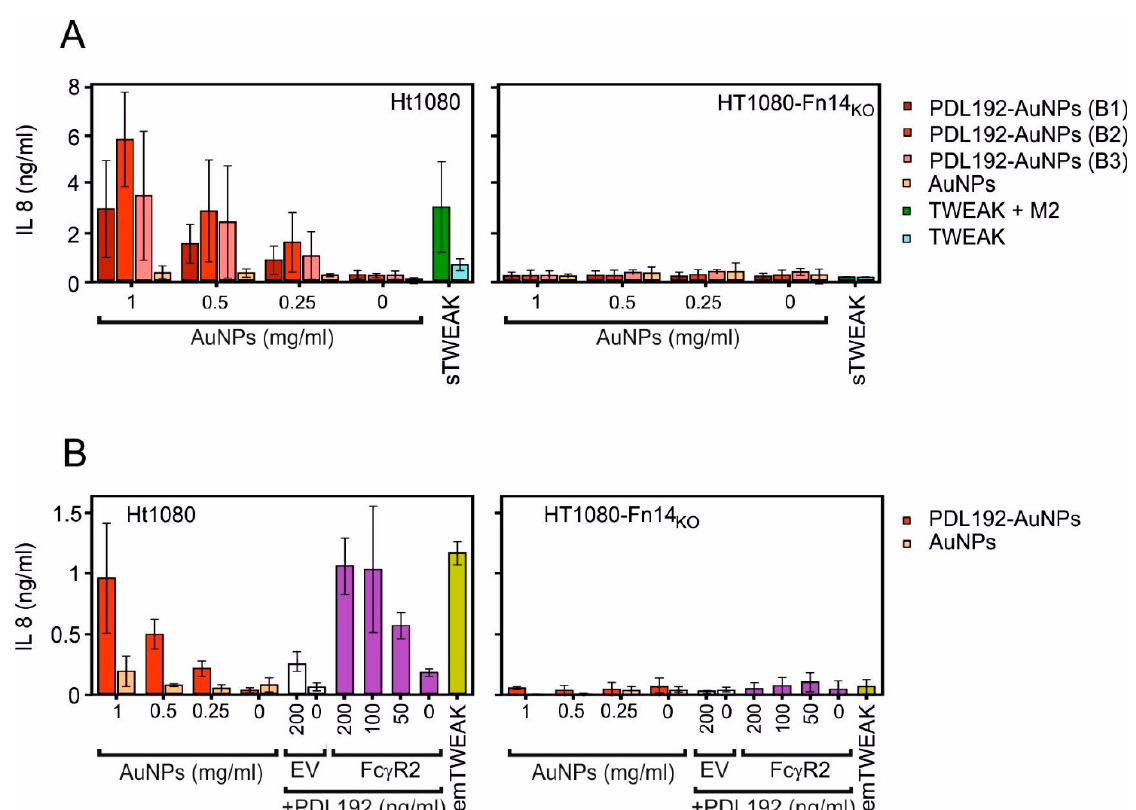
Figure 5. AuNPs-immobilized anti-Fn14 antibody triggers IL-8 production in a similar fashion to cell-anchored antibodies or membrane-bound TWEAK . HT1080 or HT1080-Fn14-knockout cells (15 × 10 3 /well) were seeded in 96-well plates,